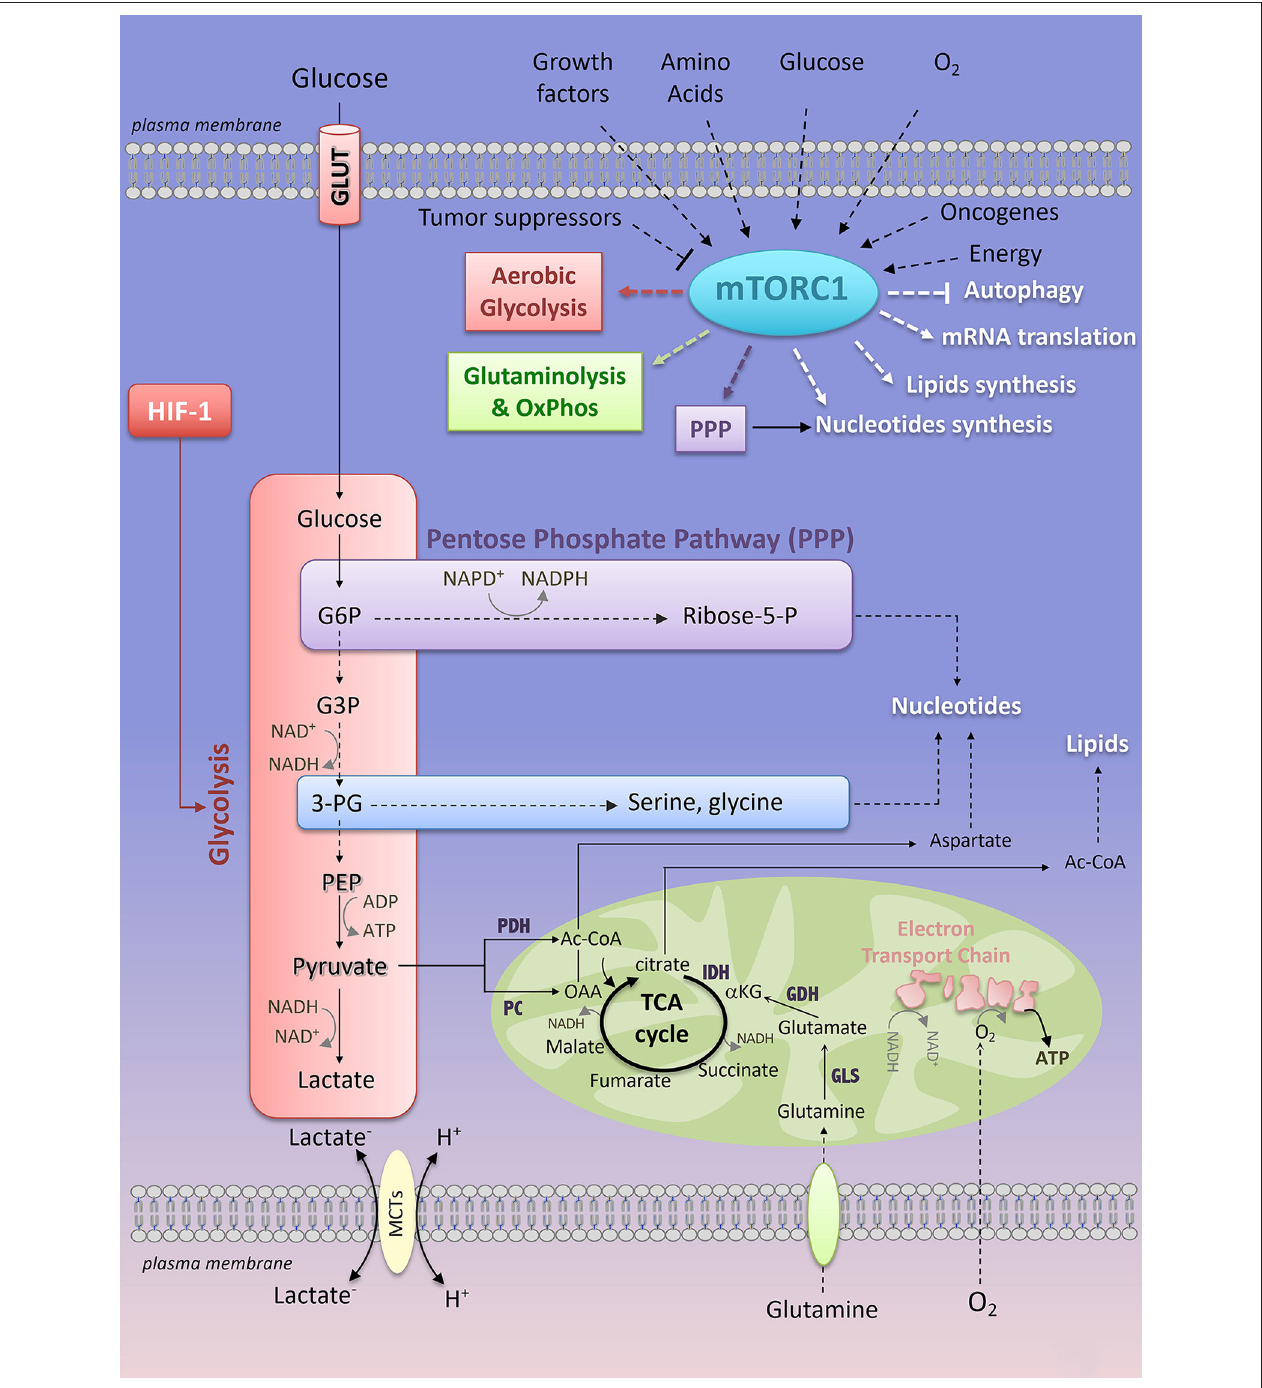
FIGURE 2 | Key interconnected metabolic pathways and their relevance to mTORC1 activation. Extrinsic (growth factors, amino acids, oxygen, glucose) and intrinsic (oncogene, energy levels) factors activate mTORC1 signaling, while tumor suppressors prevent its activation. In turn, mTORC1 enhances glycolysis, through HIF-1-dependent glycolytic program, the pentose phosphate pathway, and glutamine metabolism. mTORC1-dependent regulation of cell metabolism converges through an anabolic program resulting in increased nucleotides, protein and lipid synthesis while inhibiting autophagy. mTORC1, mTOR complex 1; PPP, pentose phosphate pathway; HIF-1, Hypoxia-Inducible Factor-1; LDH, lactate dehydrogenase; PDH, pyruvate dehydrogenase; PC, pyruvate carboxylase; IDH, isocitrate dehydrogenase; GDH, glutamate dehydrogenase; GLS, glutaminase; Ac-CoA, Acetyl-CoA; OAA, oxaloacetate; α -KG, α -ketoglutarate; G6P, glucose-6-phosphate; G3P, glyceraldehyde-3-phosphate; 3-PG, 3-phosphoglycerate; PEP, phosphoenolpyruvate; Ribose-5-P, Ribose-5-phosphate; ADP, adenosine diphosphate; ATP, adenosine 5 ′ -triphosphate; NAD + , nicotinamide adenine dinucleotide; NADH, reduced form of NAD + ; NADP + , nicotinamide adenine dinucleotide phosphate; NADPH, reduced form of NADP +